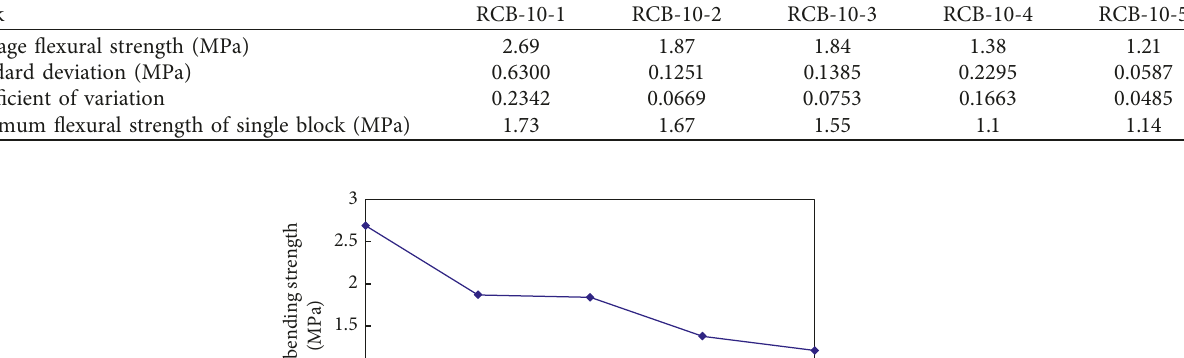
Table 10: Summary of the test results of flexural strength of recycled blocks with different substitution rates of MU10. Block